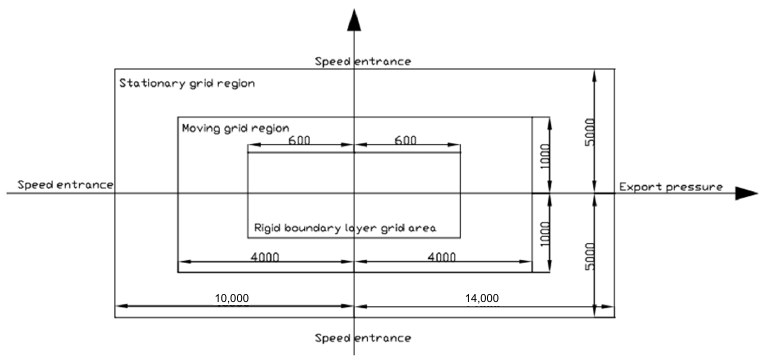
Figure 7. Schematic diagram of calculation model and subregional model (mm).